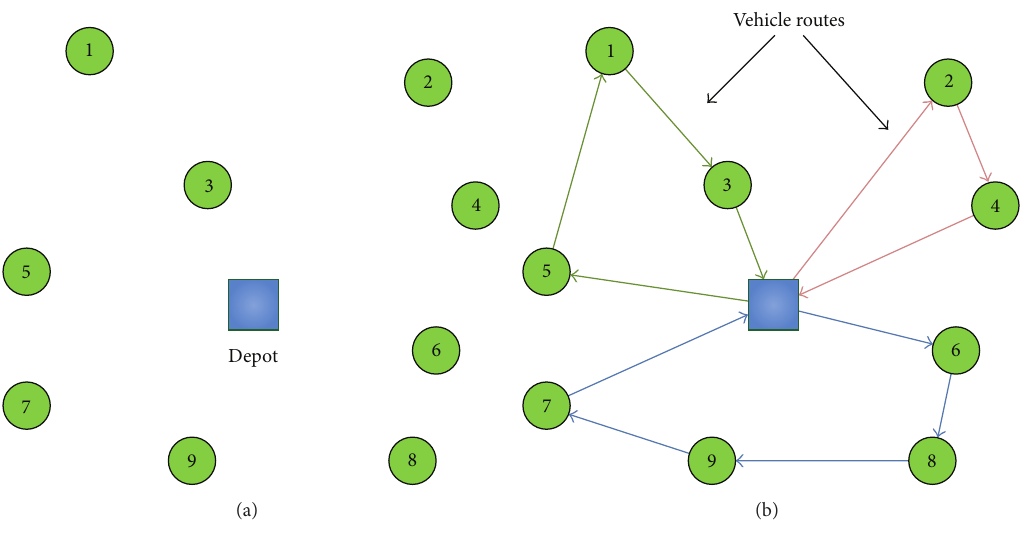
Figure 2: Example of CVRP instance and possible solution.